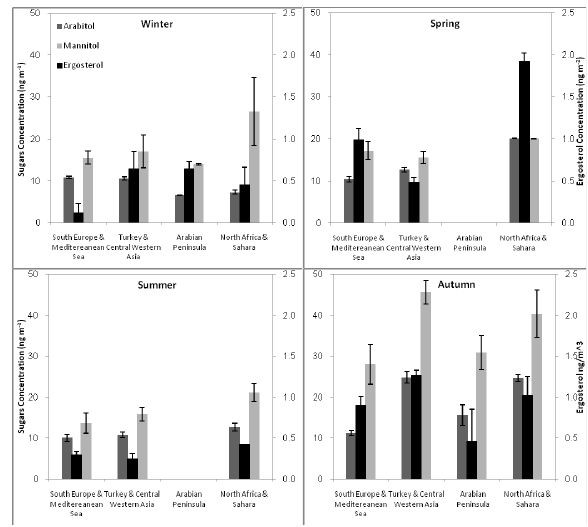
Fig. 11. Average concentrations of the biomarkers divided to the typical air mass sectors, according to